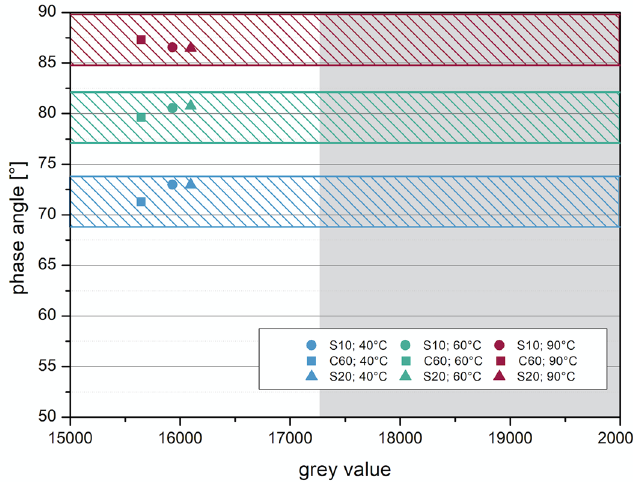
Figure 16. Correlation between phase angle and gray value—barite sand.